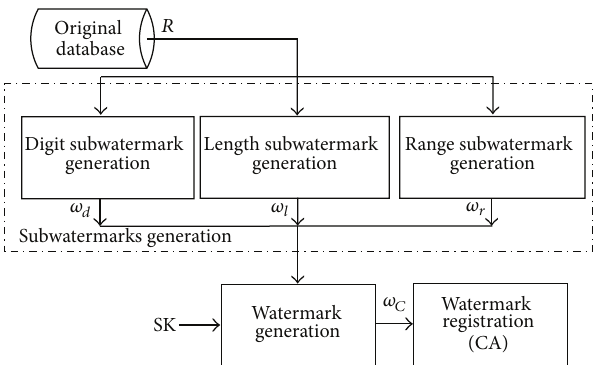
Figure 1: Proposed model for watermark generation and registra-